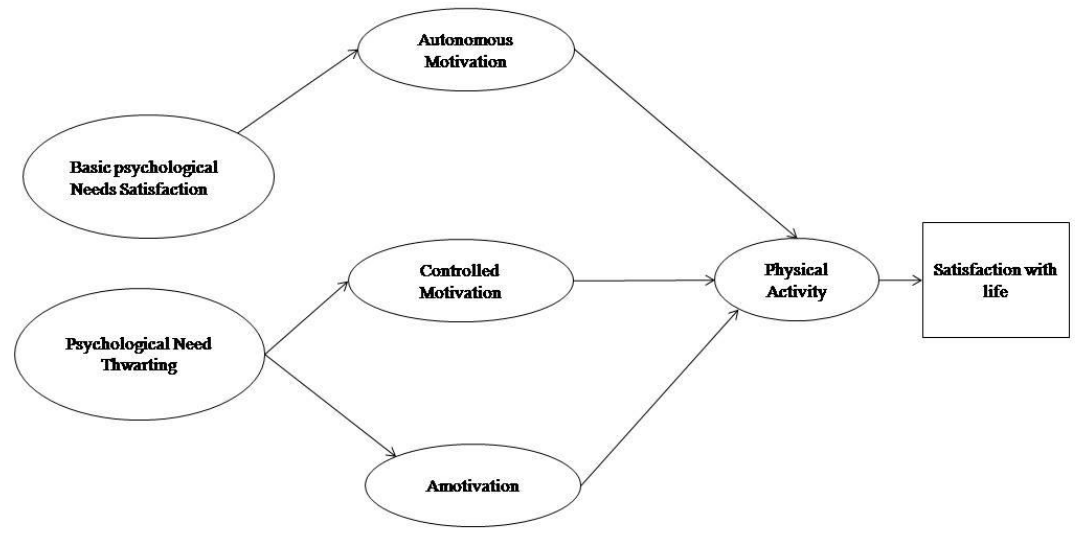
Figure 1. Hypothesized model in